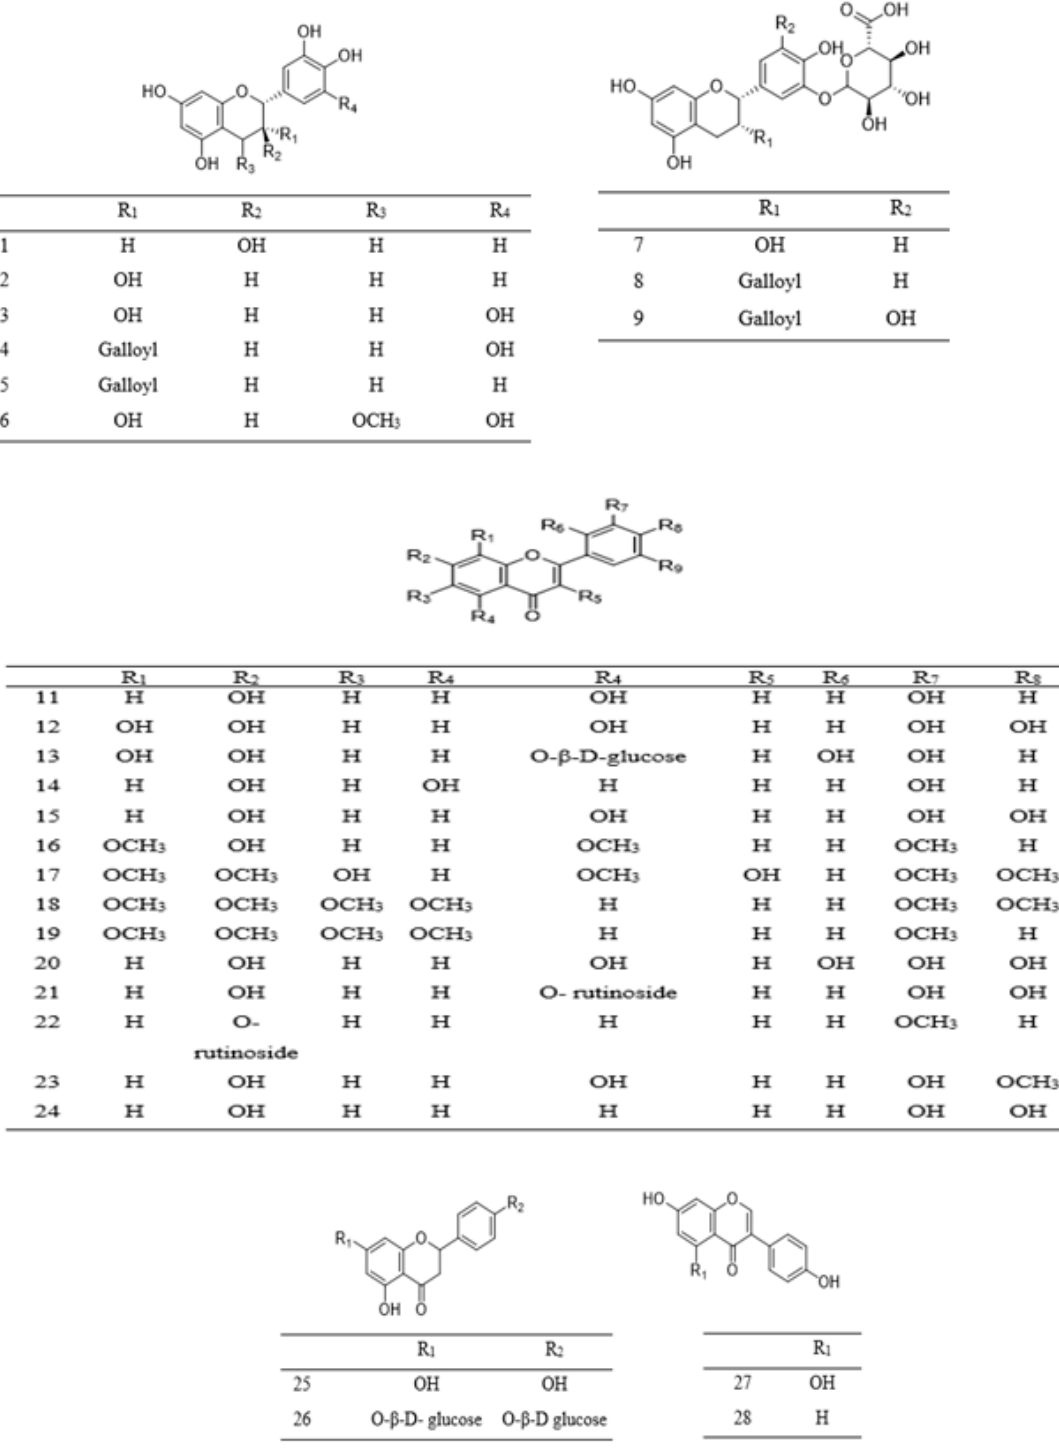
Figure 2. Structural formulas of polyphenolics 1 – 28 , as previously listed in Table 2.